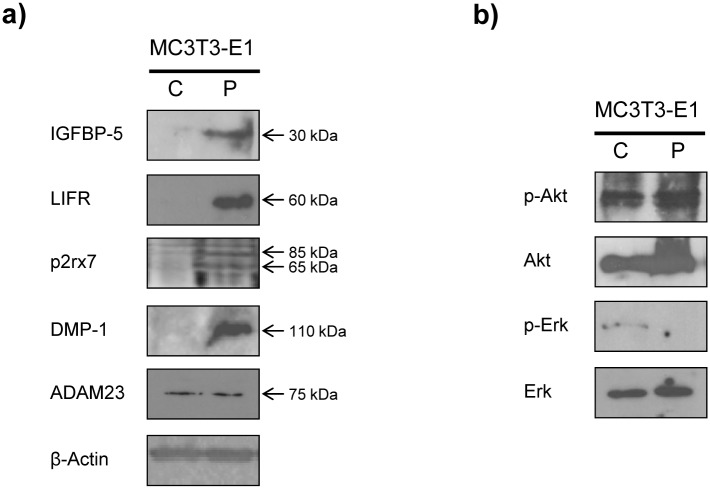
Western-blots detection of proteins whose genes are differentially expressed upon periostin overexpression.a) Proteins detected are indicated on the left and, on the right, molecular weight of detected bands. P2rx7: arrows indicate glycosilated form (top) and unglycosilated form (bottom). LIFR: the truncated form of 60 kDa is shown. b) Levels of p-Akt and p-Erk. C, control cells. P, periostin overexpressing cells.